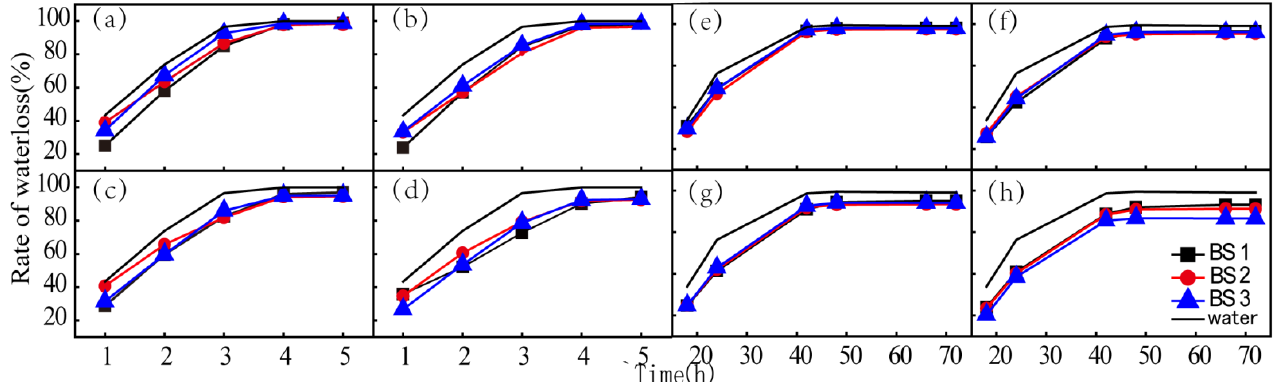
Figure 1. ( a – d ) Curves of water loss rate of humectants with concentrations of 2%, 4%, 6%, and 8% at 65 °C, respectively; ( e – h ) Curves of water loss rate of humectants with concentrations of 2%, 4%, 6%, and 8% under natural conditions, respectively.